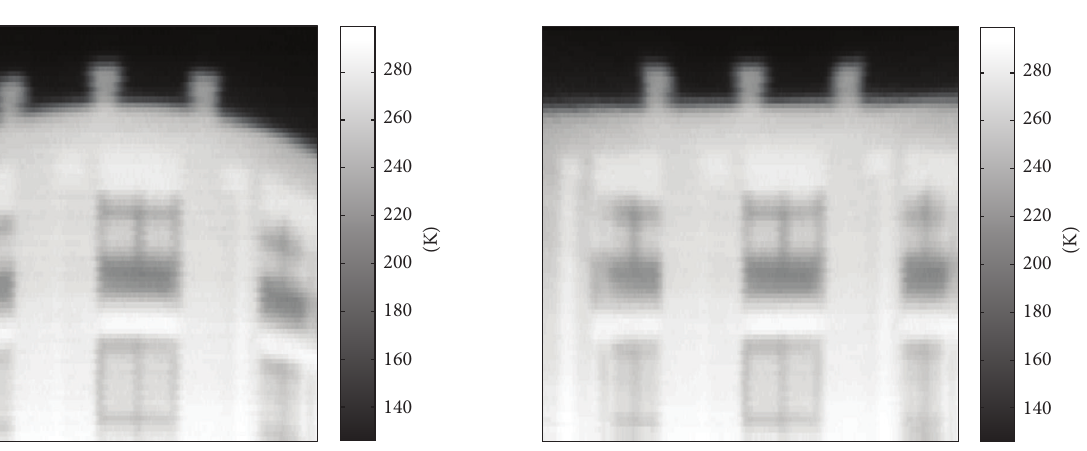
Figure 13: A passive image of the building suffered from distortion.